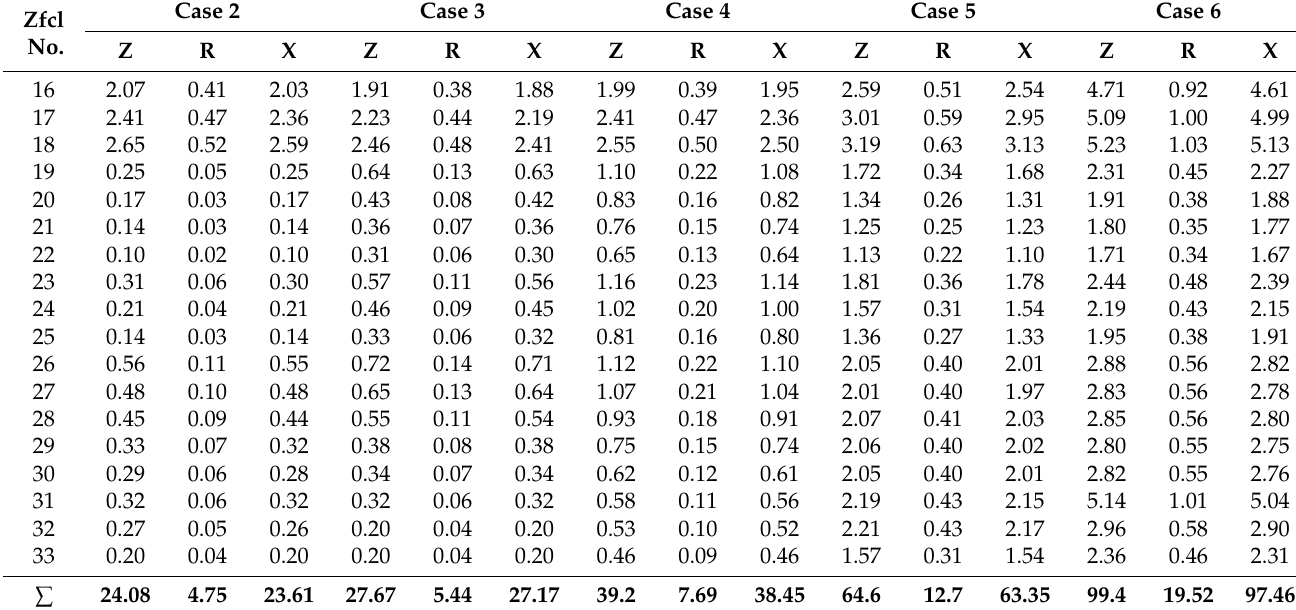
Table 3. Relay TMS parameter optimization using the GWO algorithm for different cases. Relay No.